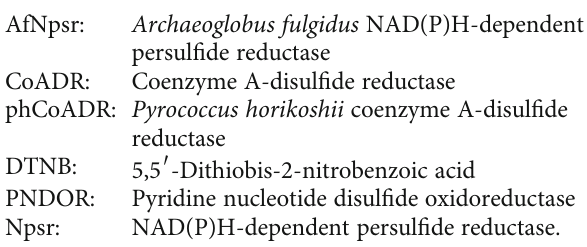
Figure S1: codon optimized A. fulgidus Npsr gene WP_ 010877907.1. Figure S2: metal binding site adjacent to FAD. Figure S3: composite omit electron density map of the ordered and disordered active site surface loop above coen- zyme A. (Supplementary